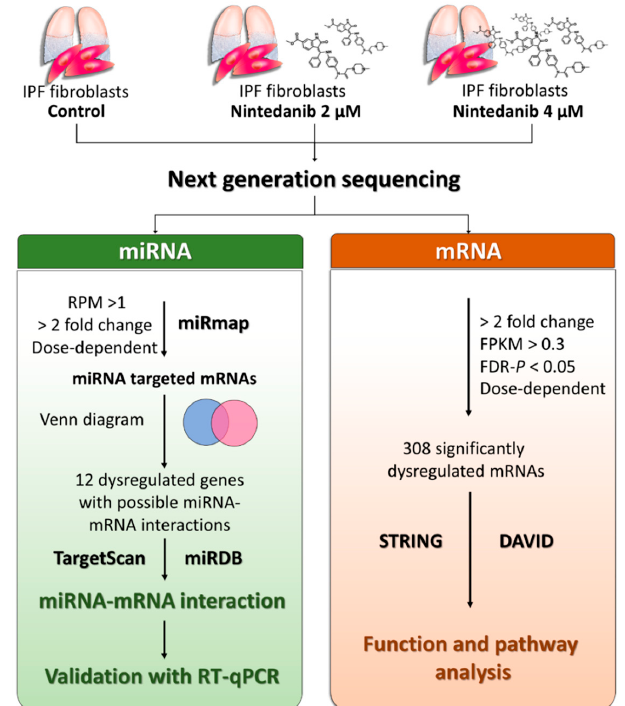
Figure 1. Flowchart of study design. Idiopathic pulmonary fibrosis fibroblasts (the second